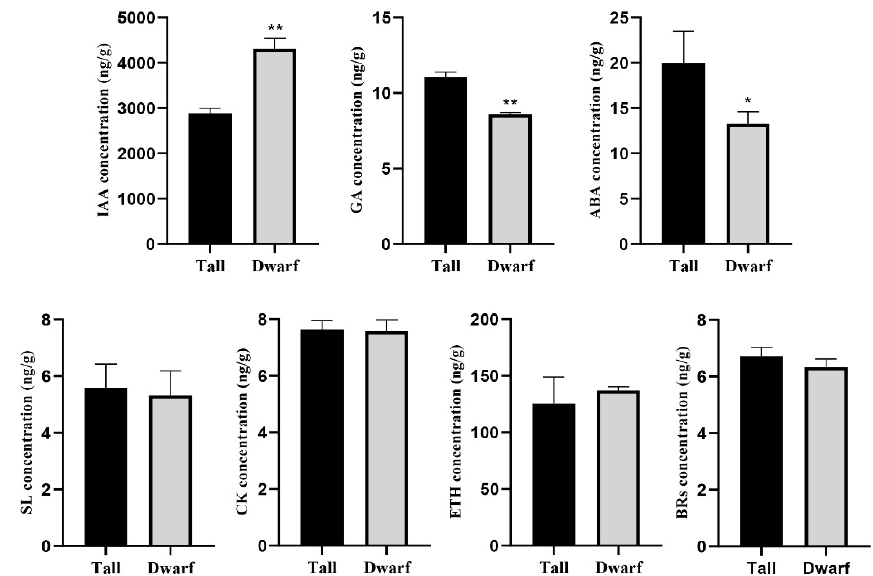
Figure 2. Concentrations of IAA, GA, ABA, SL, CK, ETH, and BRs between tall and dwarf plants ( Brassica napus ). Student’s t -test was used to compare their mean ( ± SE) values. Asterisks indicate significant differences: * p < 0.05 and ** p < 0.01.